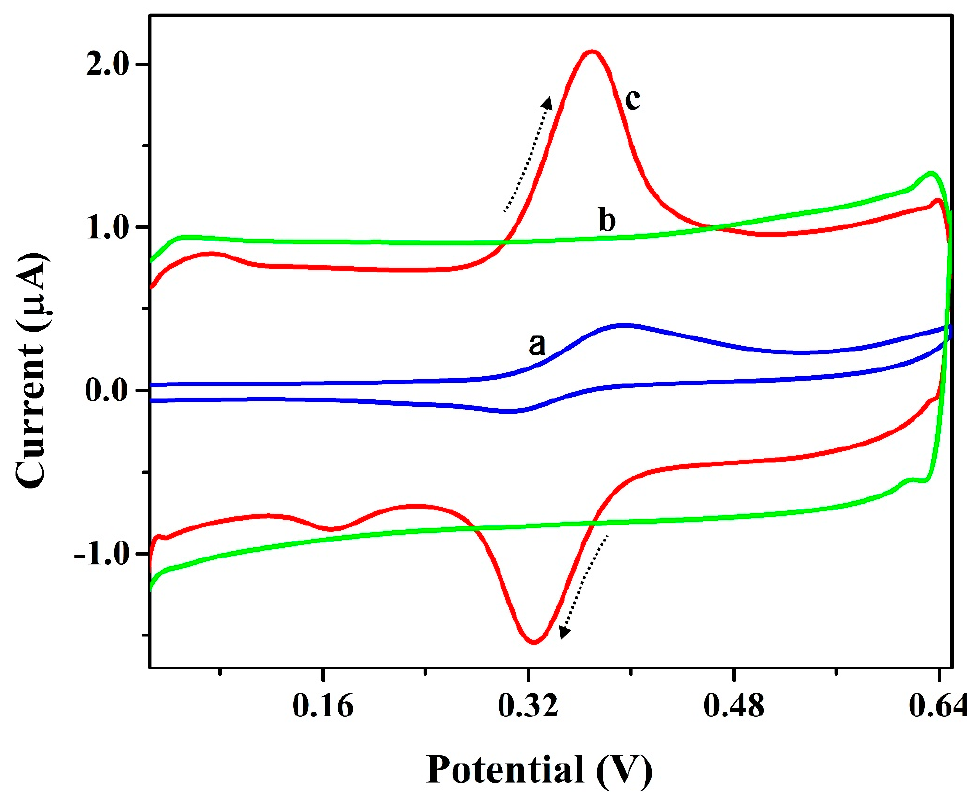
Figure 5. Cyclic voltammograms for the presence and absence (blank: curve-b) of 0.1 mM ICN in 0.2 M PB (pH 6.5) at the surface of P(PAN)LCNTPE (curve-c) and BCNTPE (curve-a) with a scan rate of 0.1 Vs − 1 .